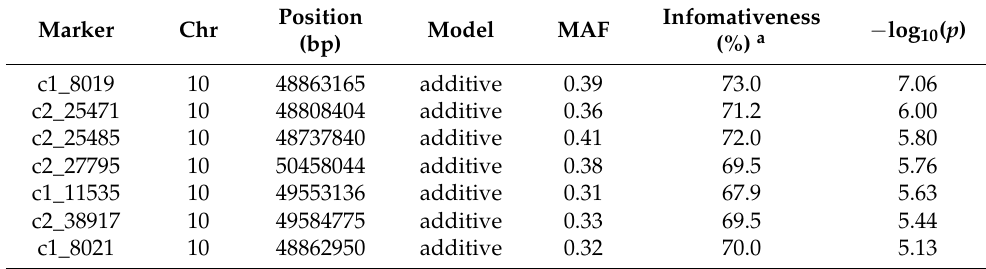
Table 1. Summary of top significant SNPs associated with chip processing.